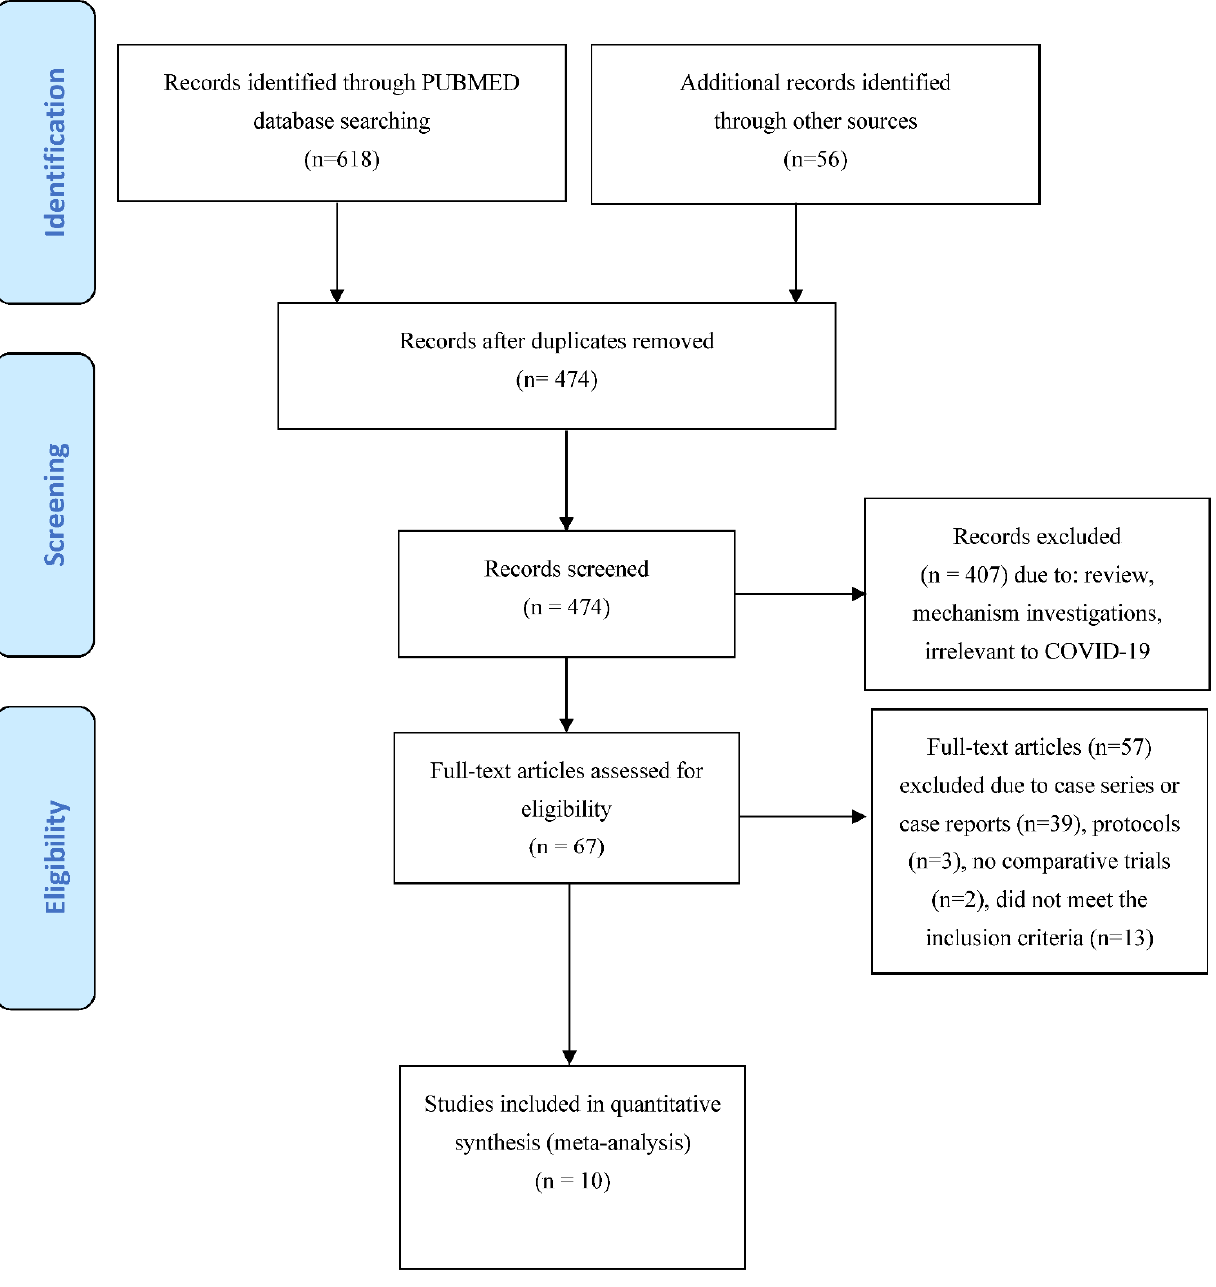
Figure 1. PRISMA flow diagram of study selection.